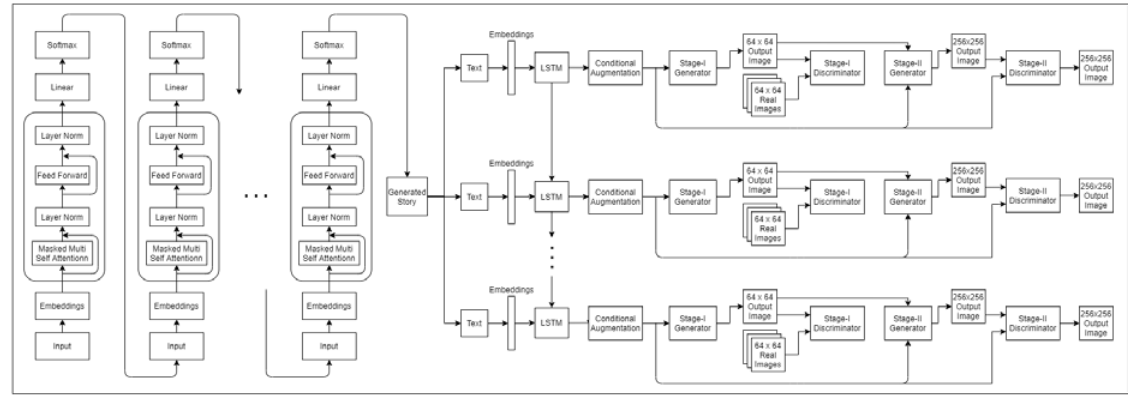
Fig. 3.1. Illustration of proposed